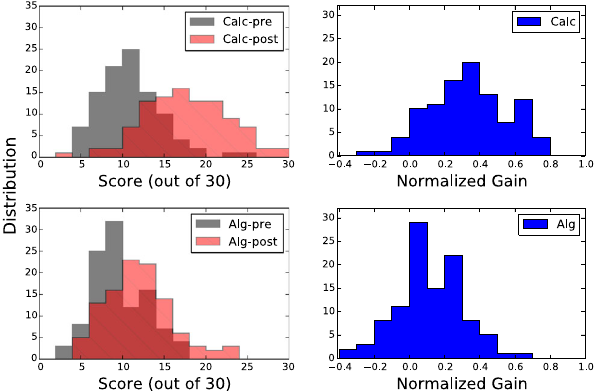
FIG. 6. Top left: Distribution of EMCA pretest scores (gray histogram) and post-test scores (red histogram) for students in calculus-based courses. Top right: Normalized gain values for students in the calculus-based courses. Bottom left: Distribution of EMCA pretest scores (gray histogram) and post-test scores (red histogram) for students in algebra-based courses. Bottom right: Normalized gain values for students in the algebra-based courses. Students in our calculus-based courses have higher post- test and normalized gain